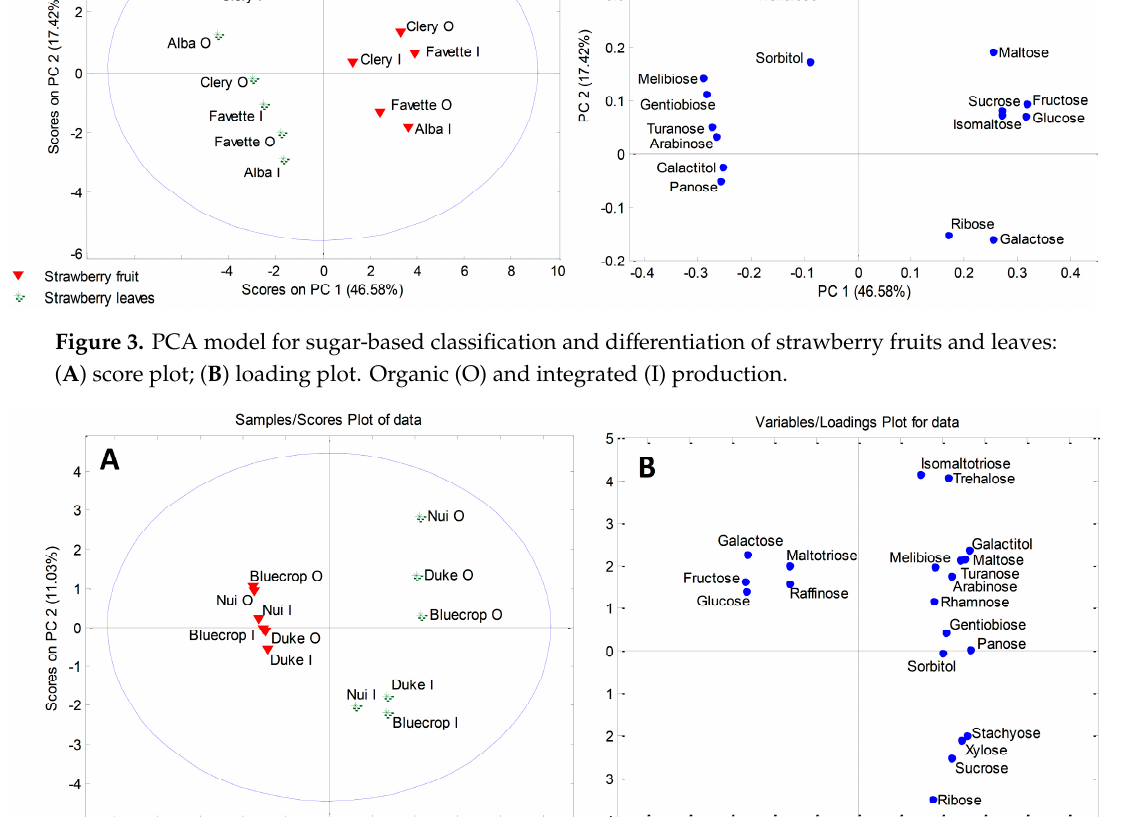
Figure 4. PCA model for sugar-based classification and differentiation of blueberry fruits and leaves: ( A ) score plot; ( B ) loading plot. Organic (O) and integrated (I) production.